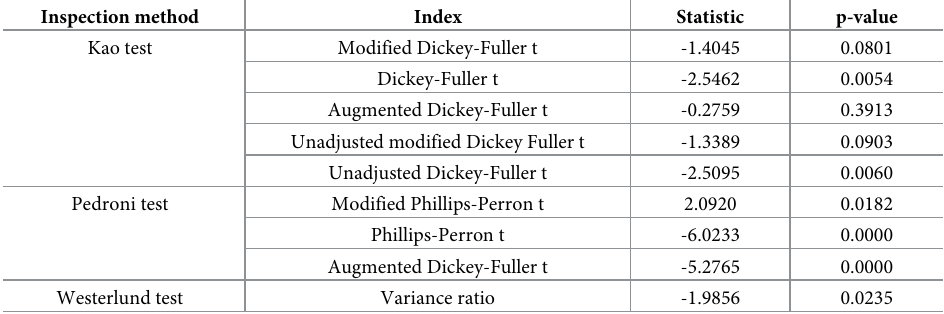
Table 6. Cointegration test of logistics industry and the comprehensive technical efficiency of manufacturing industry.